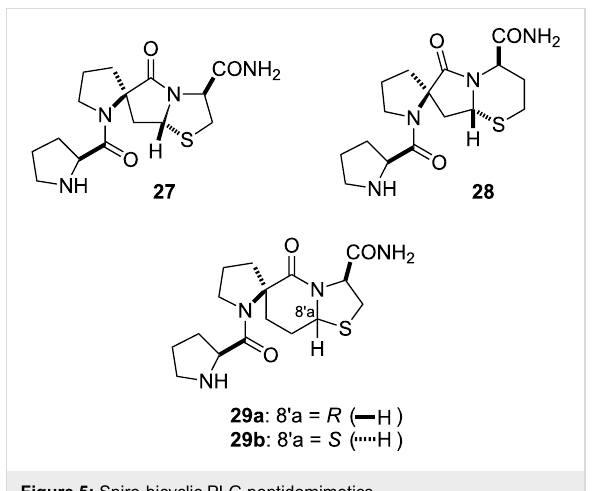
The synthetic approach to the novel highly constrained spiro- bicyclic turn mimics found in PLG peptidomimetics 27 – 29 relied on α -alkylaldehyde proline derivatives ( 34 , Scheme 1) as key starting materials [44,46]. These aldehyde intermediates were obtained from L-proline via the highly moisture-labile oxazolidinone 30 of Seebach's “self-regeneration of chirality” methodology [47]. Stereoselective alkylation of 30 provided alkylated oxazolidinone 31 and cleavage of this N , O